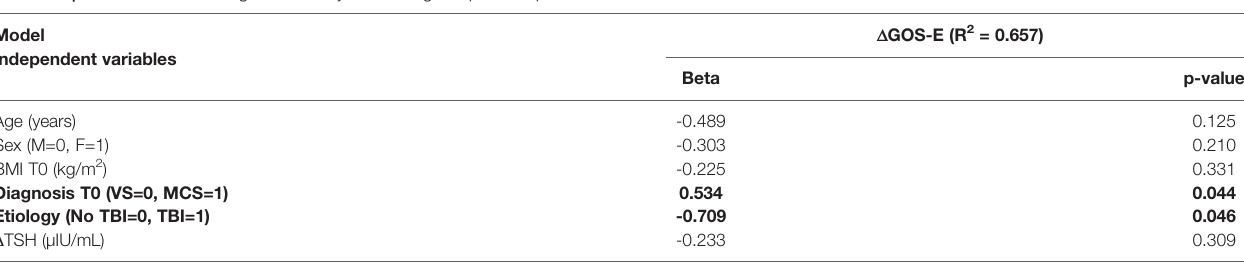
TABLE 6 | Multivariable linear regression analysis showing independent predictors for D GOS-E. Model Independent variables